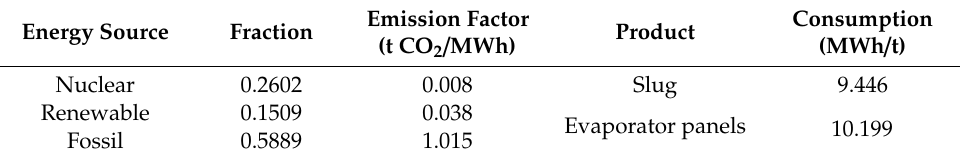
Table 1. Data used in the